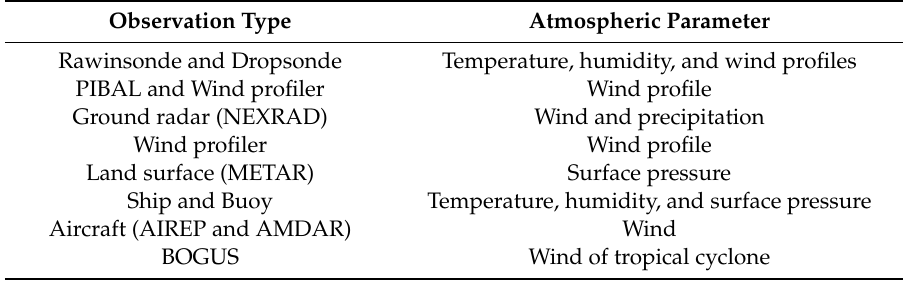
Table1. ConventionalobservationtypesusedintheGFSdataassimilationsystem. SeetheAbbreviations for an explanation of acronyms.